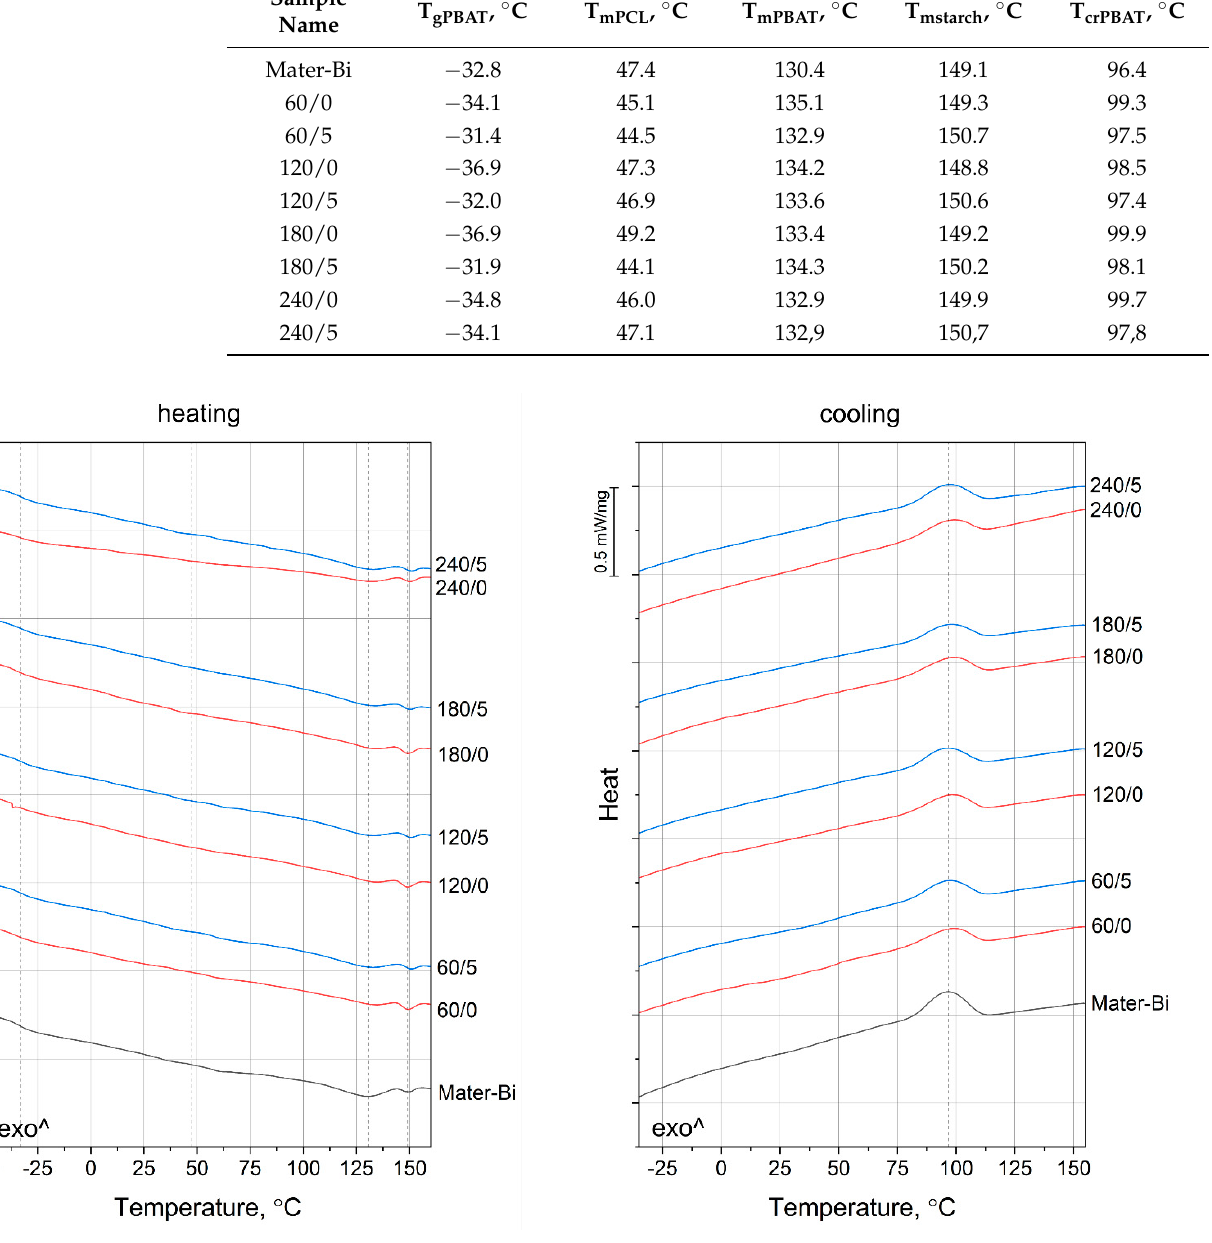
Figure 6. Values of ( a ) melt mass-flow rate and ( b ) melt volume-flow rate measured for different composite samples. Figure 7 shows the complex viscosity curves for unmodified Mater-Bi and compo- sites containing organic fillers subjected to thermomechanical and chemical treatment us- ing isophorone diisocyanate. The shape of the curves showing no low values of angular frequency Newtonian plateau is typical for starch-based thermoplastics [77]. While in the case of composite materials, there is no Newtonian behavior that may be related to solid-